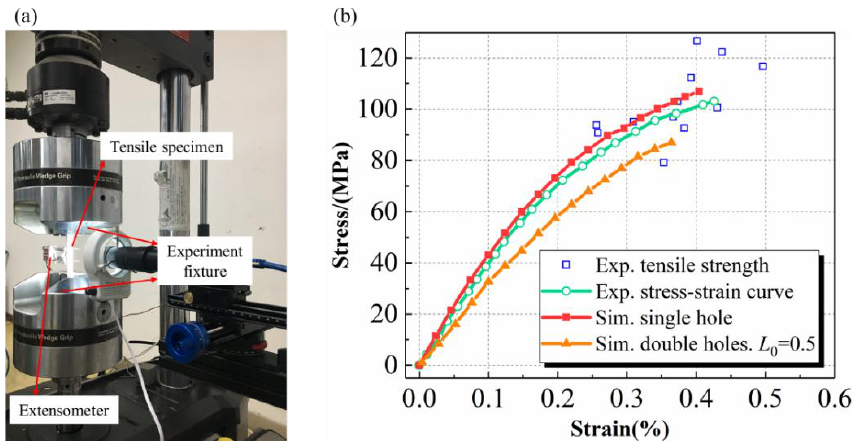
Figure 11. ( a ) The tensile specimens, experiment fixtures, and the extensometer ( b ) comparison of simulation and experimental results for tensile stress-strain curve